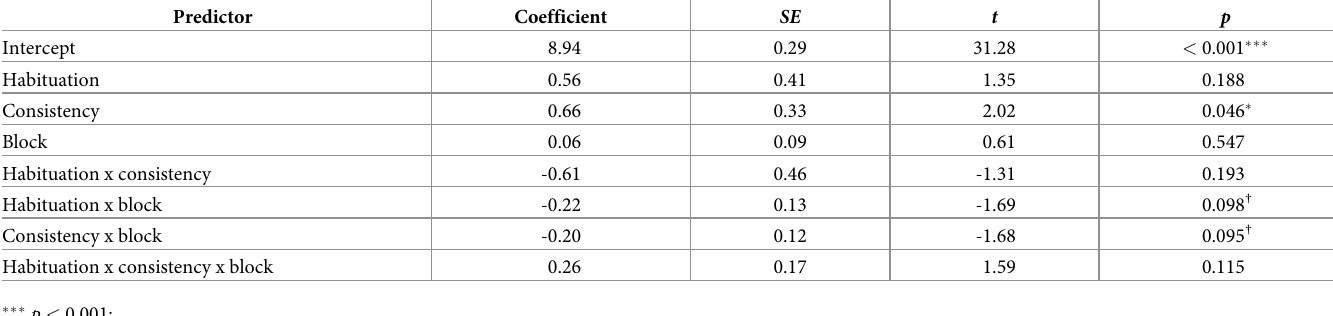
Table 1. Summary of the fixed effects in the mixed effect linear regression model incorporating habituation condition, test consistency, block, and their interactions for Experiment 1. Predictor Coefficient SE t p